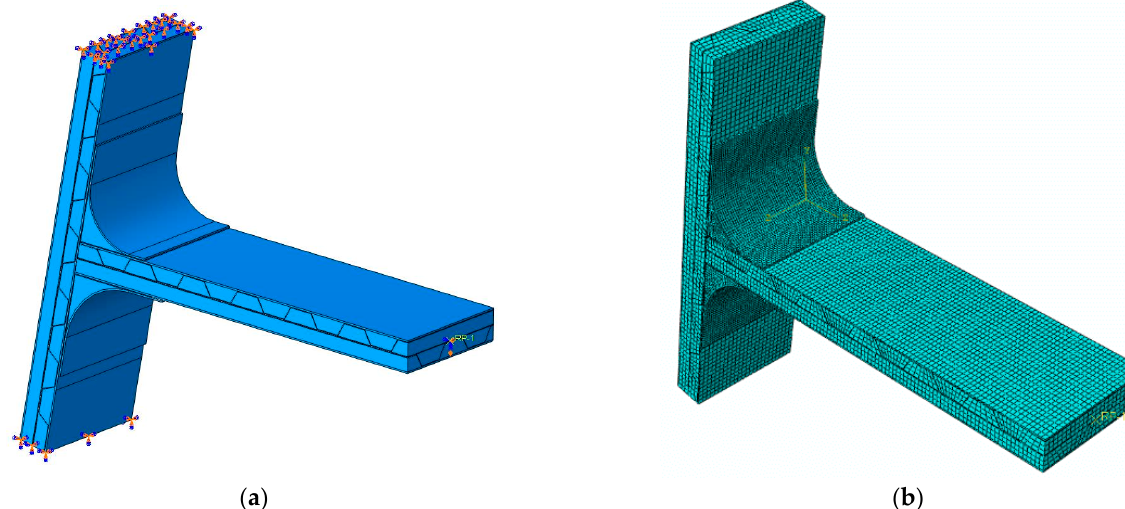
Figure 7. Finite element ( a ) geometric model and ( b ) mesh model.